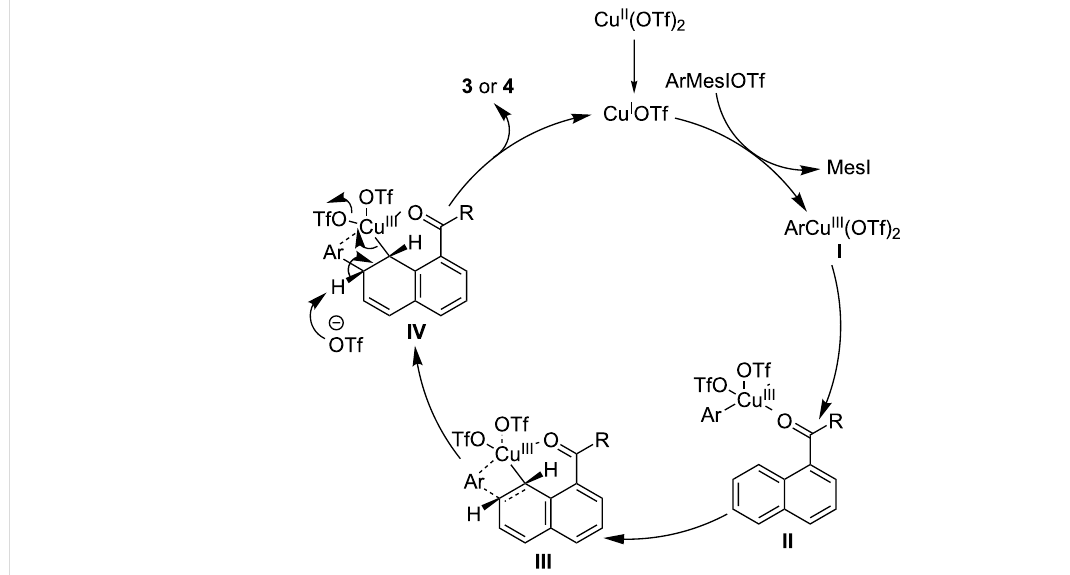
Scheme 4: Proposed catalytic cycle.